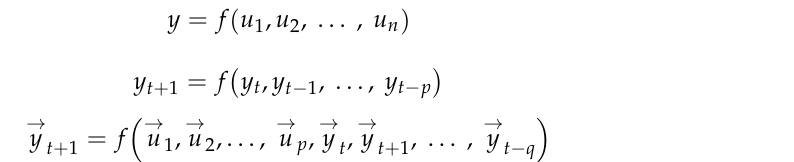
Figure 5. ANN Process Stages.